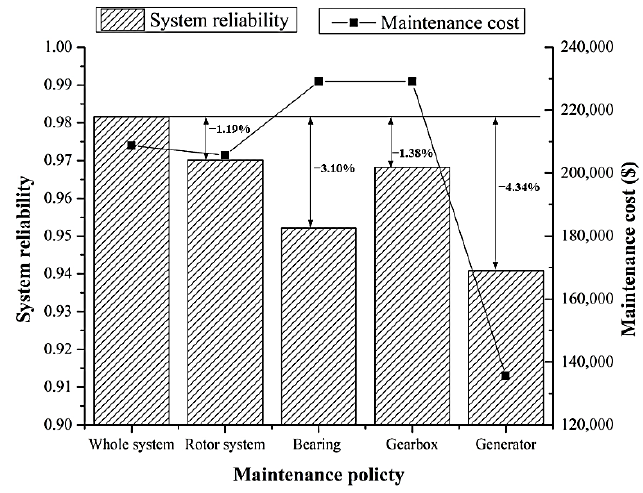
Figure 7. The maintenance cost as a function of system reliability comparison .